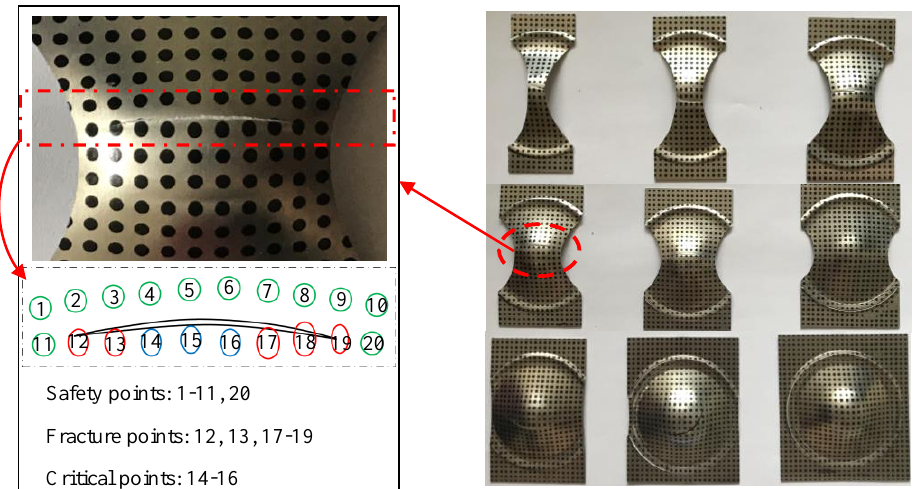
Figure 8. Deformed specimens of punch-stretch tests.